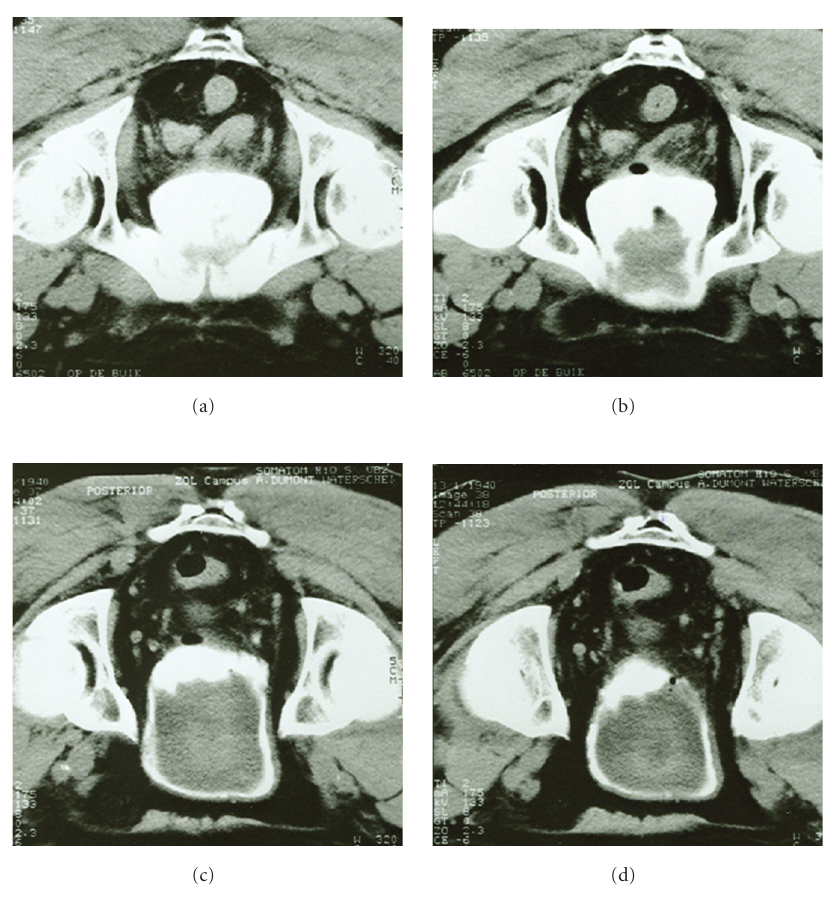
Figure 1: Contrast enhanced CT-scan of the abdomen (prone position), showing a large bladder mass, protruding the bladder and almost completely filling up the bladder